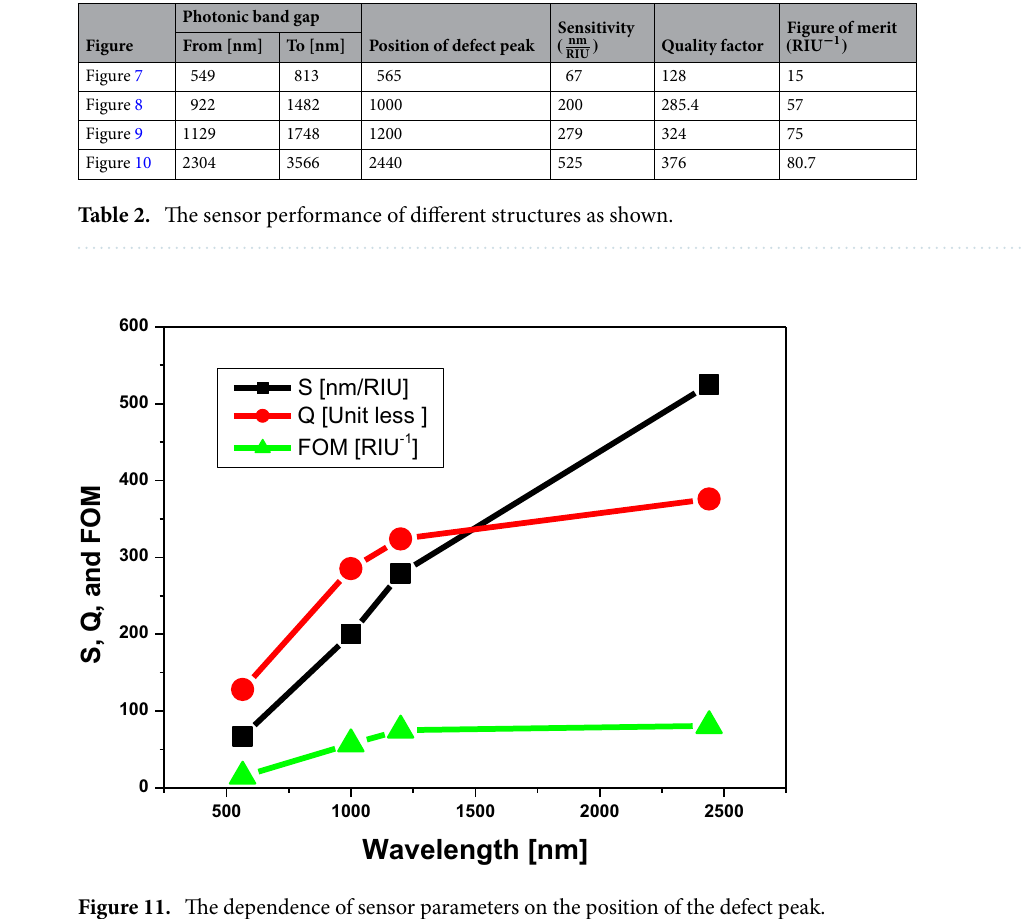
Sensitivity ( nm RIU ) Quality factor